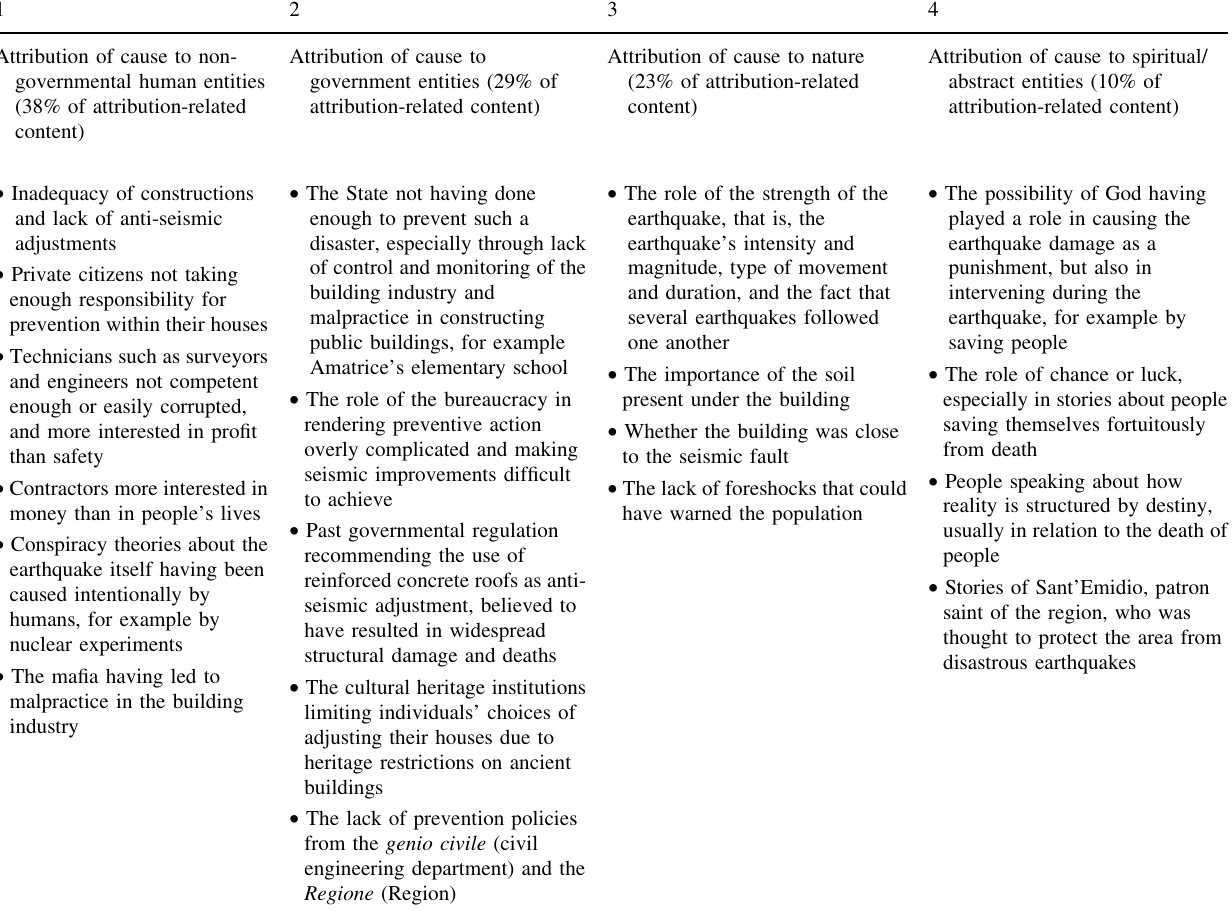
Table 3 Theme summary of the interview representations of causation for the earthquake